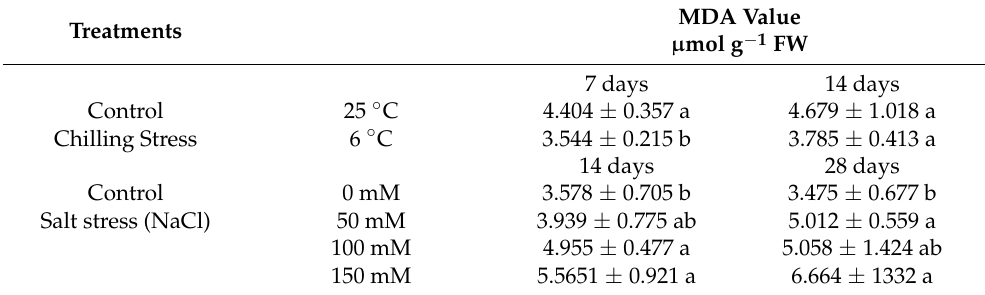
Table 3. Lipid peroxidation of cardoon calli in response to 7 and 14 days of chilling at 6 ◦ C or 14- and 28 days of 0, 50, 100, or 150 mM NaCl stress, as measured by the MDA assay. Each MDA value ( µ mol g − 1 FW) represents the mean of three biological replicates ± SD. Statistical significance between treatments within each time point was determined by one-way ANOVA with Tukey’s post hoc test. Different letters indicate significant differences ( p -value < 0.05).